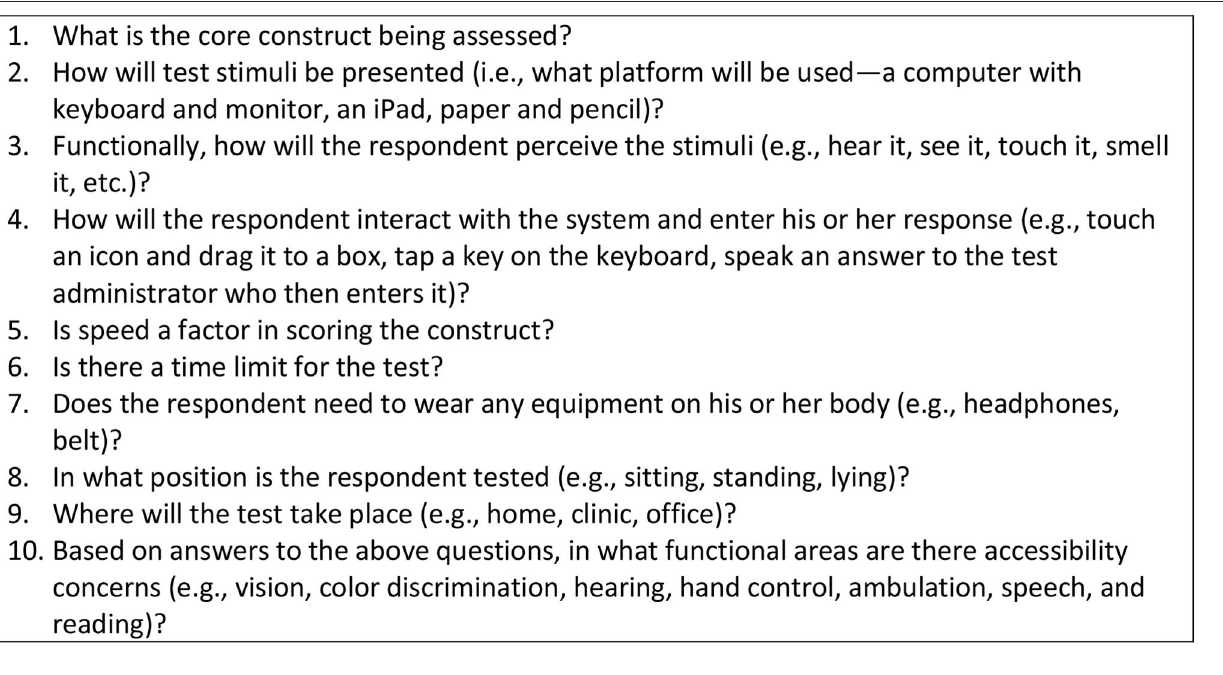
FIGURE 3 | Accessibility questions for test developers.